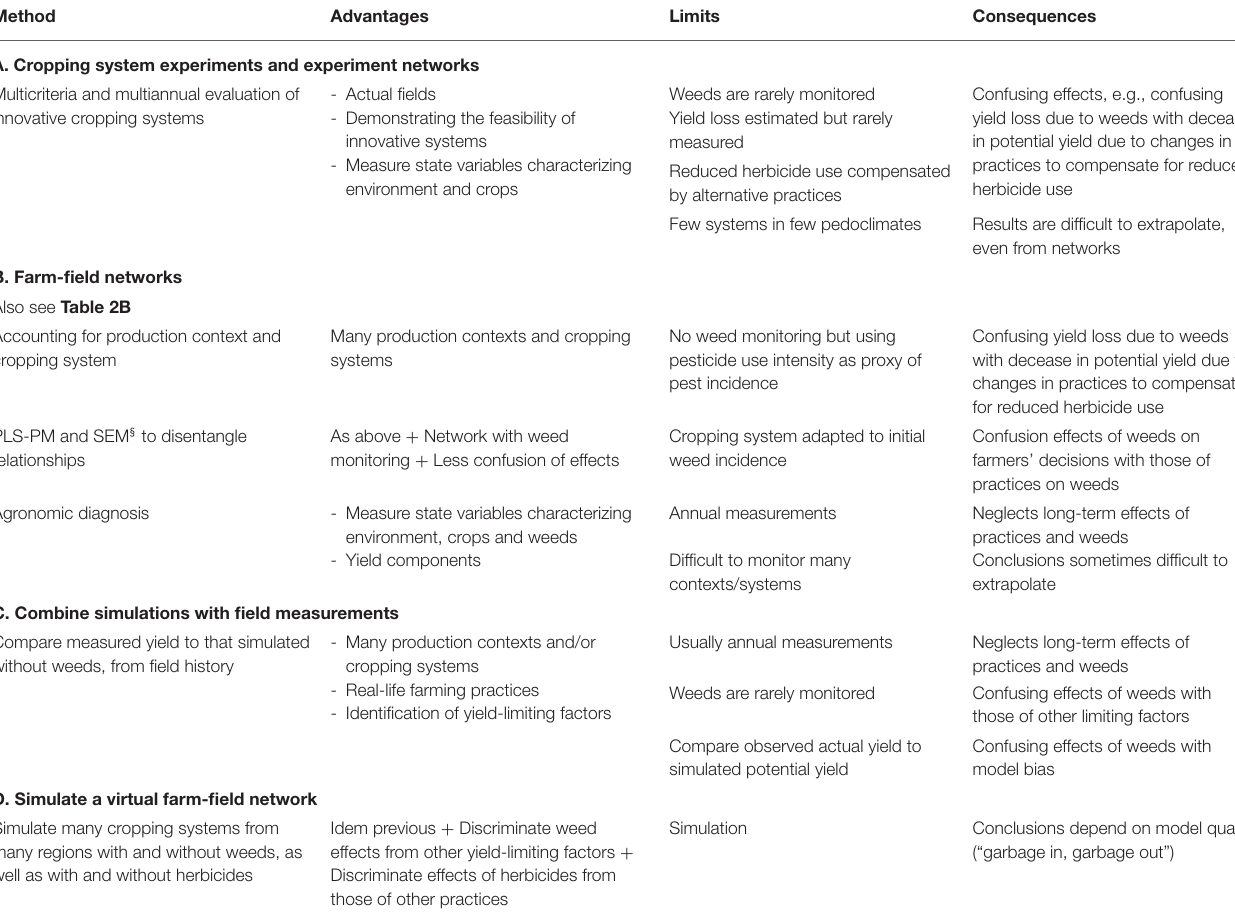
TABLE 4 | Critical synthesis of the methods investigating cropping system effects on weeds and crop yield based literature